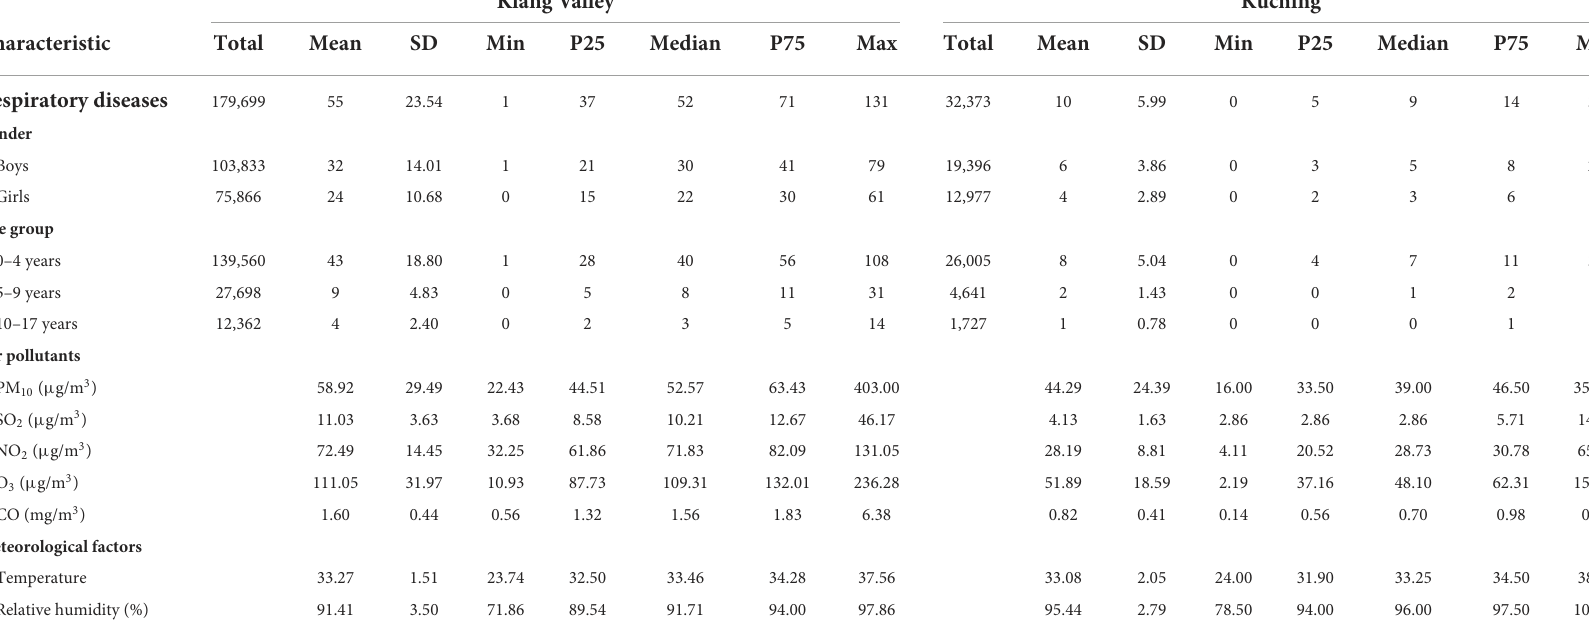
TABLE 3 Summary statistics of daily hospital admissions for respiratory diseases, air pollutants concentration and meteorological factors in Klang Valley and Kuching from 2010 to 2018. Klang Valley Kuching